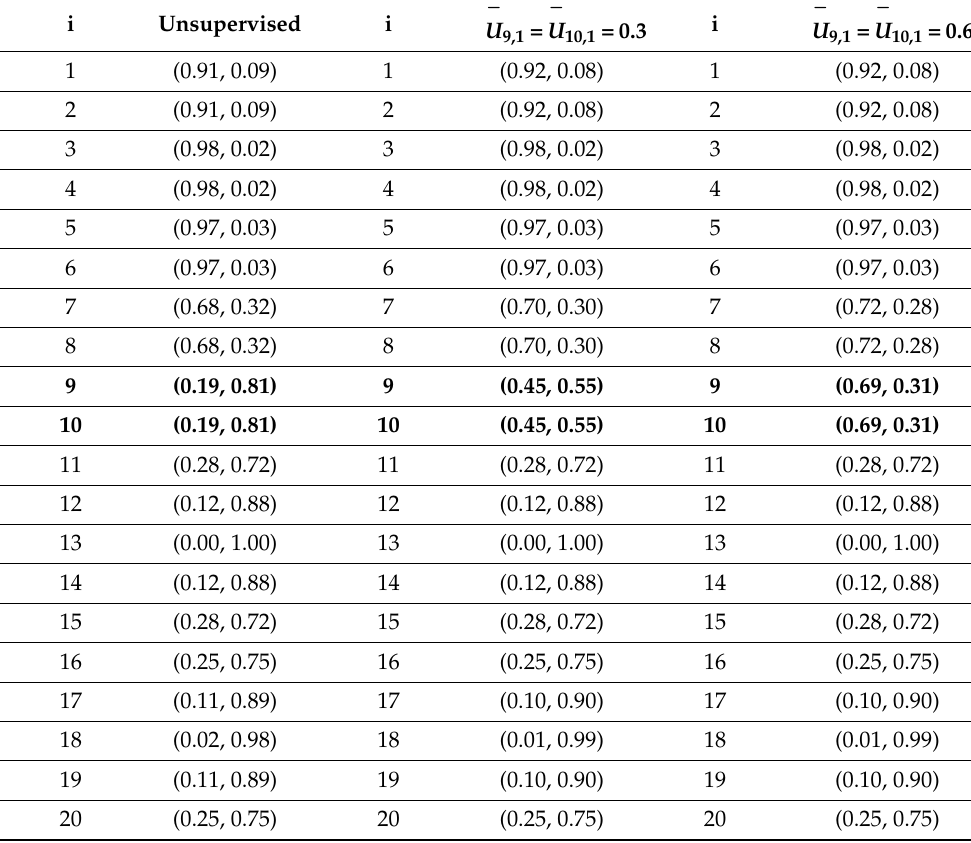
Table 2. The resulting membership U for the 3 cases using the sSFCM